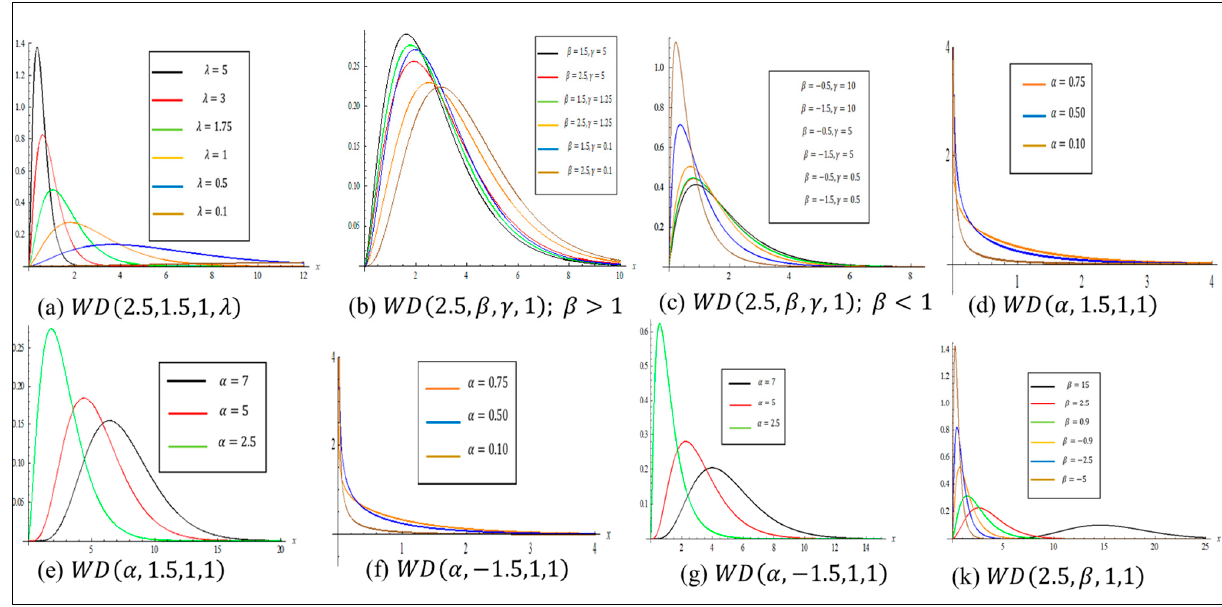
Figure 1. Plots of density function 𝑊𝐷(𝛼,𝛽,𝛾,𝜆) for some parameters values.